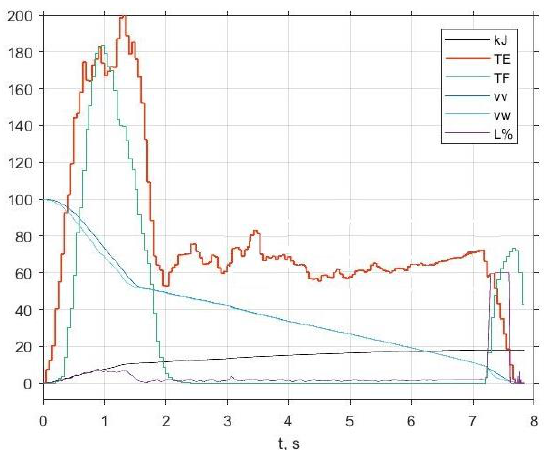
Figure 11. Simulation of the road changing from dry asphalt to icy surface.